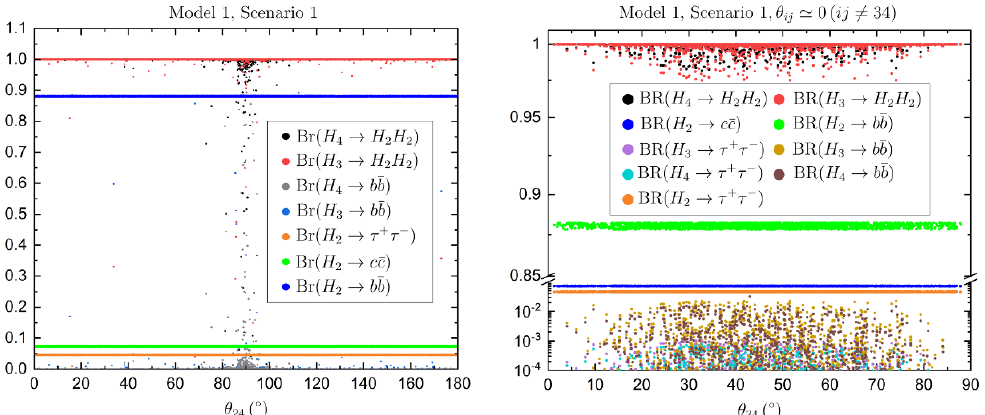
Figure 2 . Branching ratio for the new scalars into di(cid:11)erent (cid:12)nal states for scenario 1 of model 1, resulting from a scan of allowed points in parameter space. In the left panel (cid:18) 23 ; 24 vary in the interval [0 ; (cid:25) ] while in the right panel j (cid:18) 23 ; 24 j (cid:20) 0 : 01. For completeness we include the branching ratios of H 2 , which do not depend on the mixing